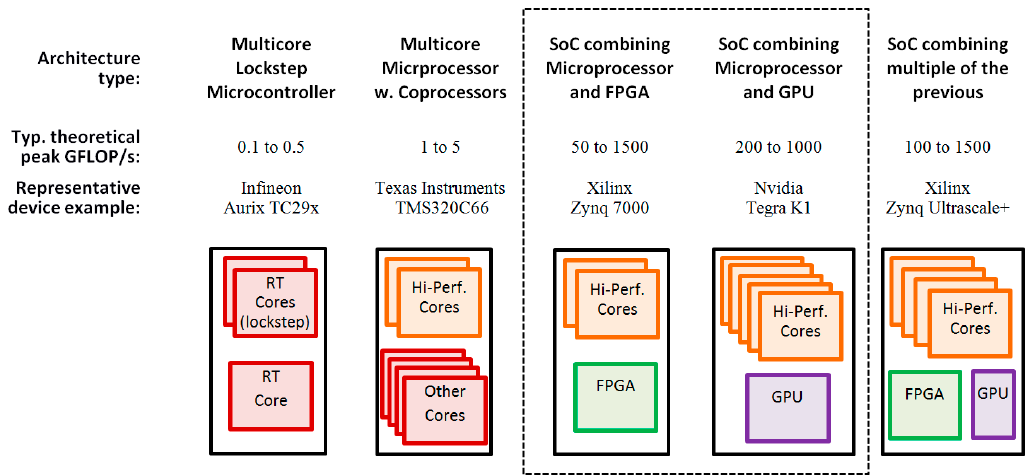
Figure 1. Overview over relevant embedded platform types in the market, illustrating a simplified block diagram of their topology, providing indicative examples of the typical theoretical peak GFLOP/s performance for each type and one representative device example. Platforms used in this work are highlighted with dashed line box [24,25,29,33].